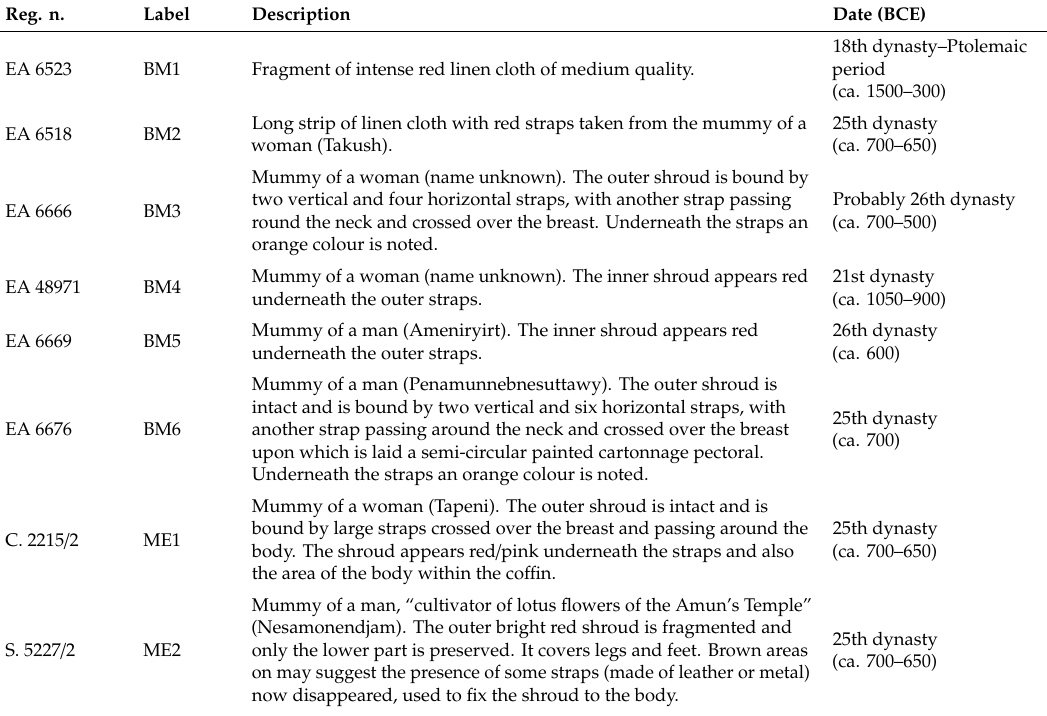
Table 1. Brief description of the textile fragments and mummies from the collections of the British Museum (BM) and the Museo Egizio (ME) under investigation in this study. Labels for the samples removed for investigation with micro-invasive techniques are also